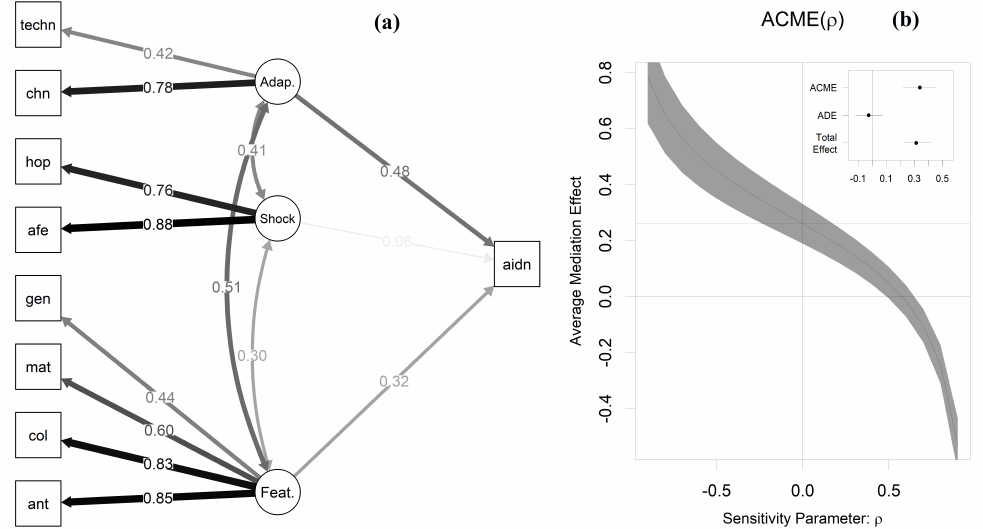
Figure 4. Causal analysis answering the question: which start-ups obtained the economic aids issued by the Colombian government? ( a ) SEM model that expresses the main contribution of three latent factors: start-up features, shock, and adaptability. ( b ) Mediation analysis that confirms that the predictive ability of start-up features upon having obtained aids is mediated by adaptability. Main figure: Sensitivity analysis figure. Inset: 95% confidence intervals that express how the total predictive power is splitted in mediated effect (ACME) and direct effect